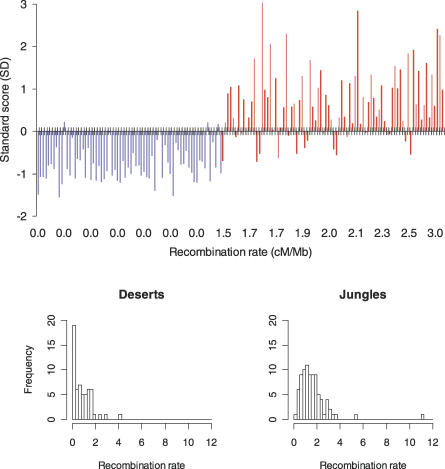
Recombination Jungles and DesertsEnrichment of CCTCCCT motif in recombination jungles (upper panel). The standard deviation (SD) from the mean number of CCTCCCT motifs is plotted against recombination rate. Red bars are 1-Mb regions included in the top 10% recombination rate in both HS and RIs (recombination jungles), and blue bars are regions in the bottom 10% (recombination deserts).Histograms of human recombination rates for the orthologous regions of the mouse recombination jungles and deserts (lower panel).